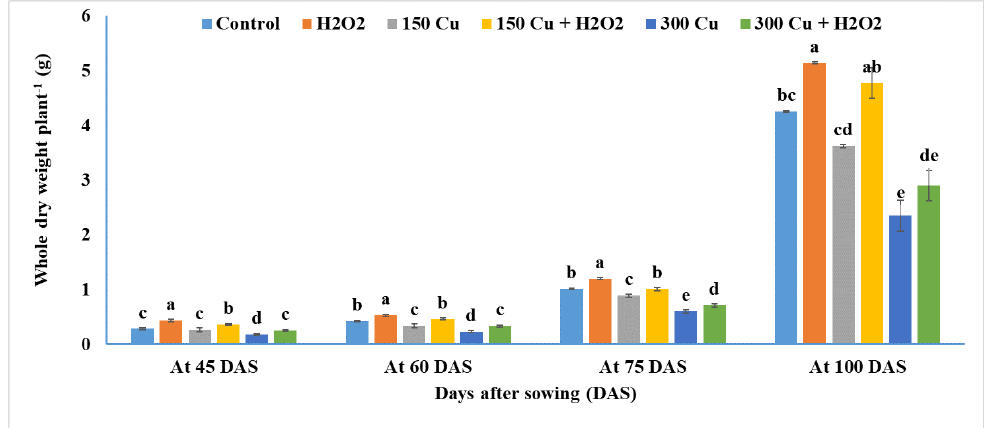
Figure 3. Effect of hydrogen peroxide on whole dry weight per plant at 45, 60, 75, and 100 DAS of wheat grown in contaminated sandy soil. Means followed by the same letter at each sampling date are not significantly different according to the least significant differences (LSD) test ( p ≤ 0.05). Error bars are ± Standard Error (SE).